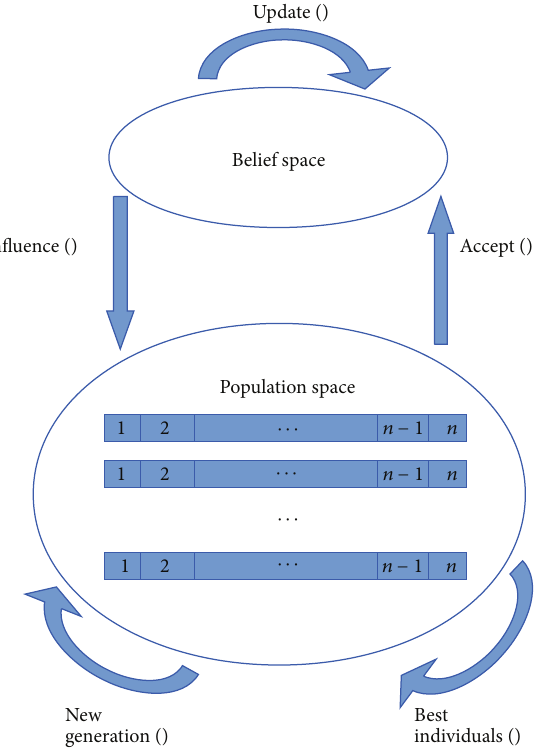
Figure 3: CA general diagram.